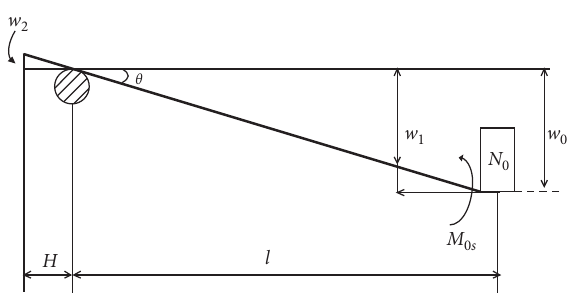
Figure 1: Displacement field of a simply supported RC beam with a heavy striker at its